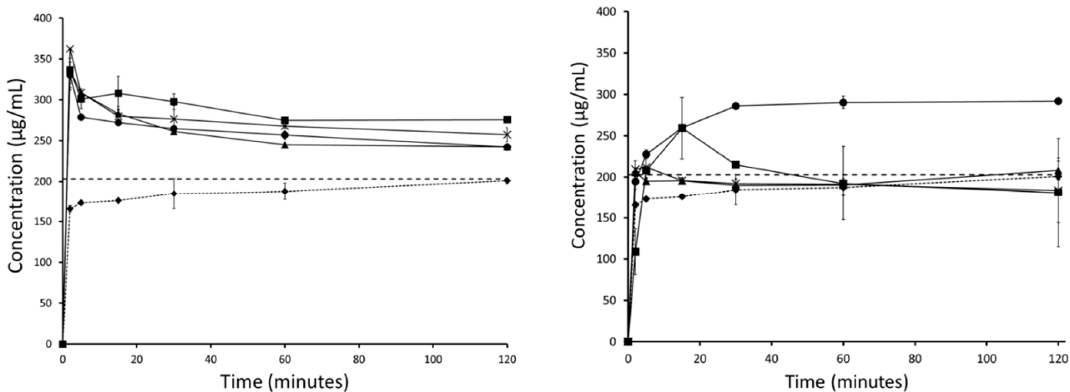
Figure 8. Fasted Simulated Intestinal Fluid (FaSSIF) mini-dissolution curves for carbamazepine loaded silica (left) and carbamazepine HME formulation (right) showing crystalline carbamazepine ( (cid:7) ), unstressed carbamazepine formulation ( ● ), and stressed carbamazepine formulations at 30 ( ▪ ), 60 (X), and 90 ( (cid:78) ) days.